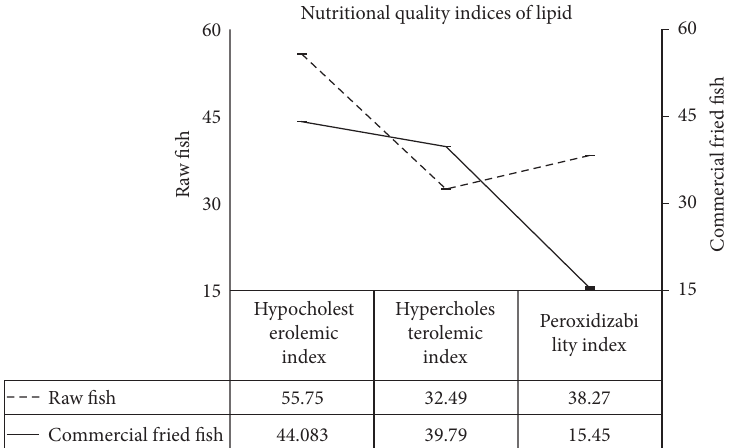
Figure 2: Hypocholesterolemic and peroxidizability index of raw and commercial fried